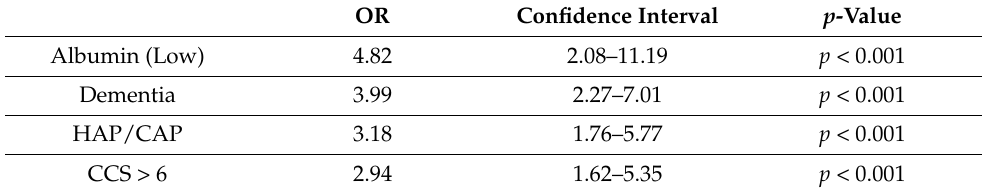
Table 2. Coefficients and odds ratio estimates of factors contributing to one-year